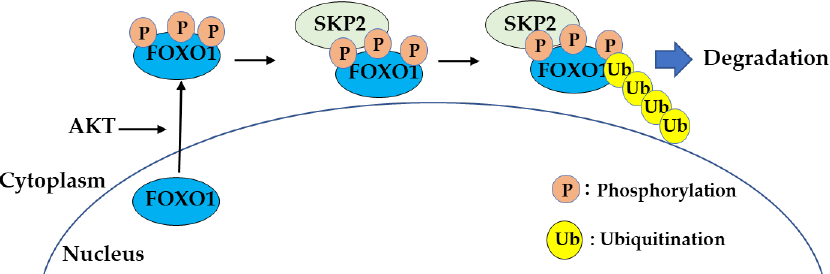
Figure 4. Forkhead box (FOXO) ubiquitination and degradation. Akt phosphorylation of FOXO and nuclear exclusion causes subsequent binding of SKP2, followed by ubiquitination and degradation. 3. Tissue-Specific Function of FOXO1-Binding Protein in Insulin Responsive Tissues